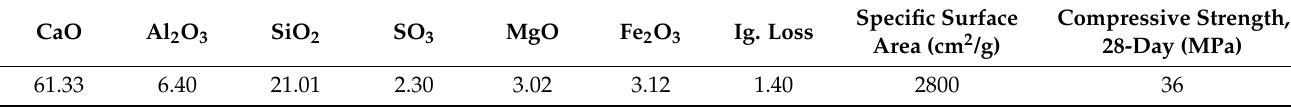
Table 4. Chemical composition and physical properties of cement.